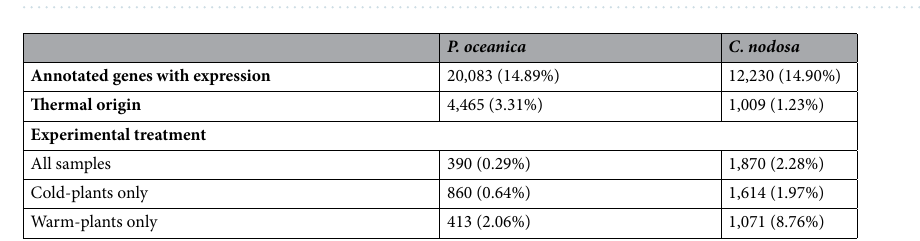
Figure 2. Variation of CpG O/E among genes assigned to different GO Slim terms (biological processes) in P. oceanica (left panel) and C. nodosa (right panel). Points represent mean CpG O/E for the corresponding biological processes (± standard error). Asterisks indicate significance of enrichment in the low- or high-CpG components (* < 0.05, ** < 0.01, *** < 0.001; Fisher’s exact test).